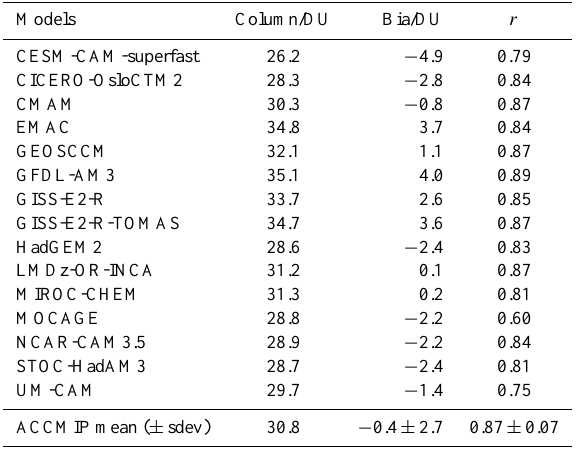
Table 3. Tropospheric ozone column, bias and spatial correation for the Hist 2000 simulation of the ACCMIP models vs. a climatology derived from OMI data (Ziemke et al.,